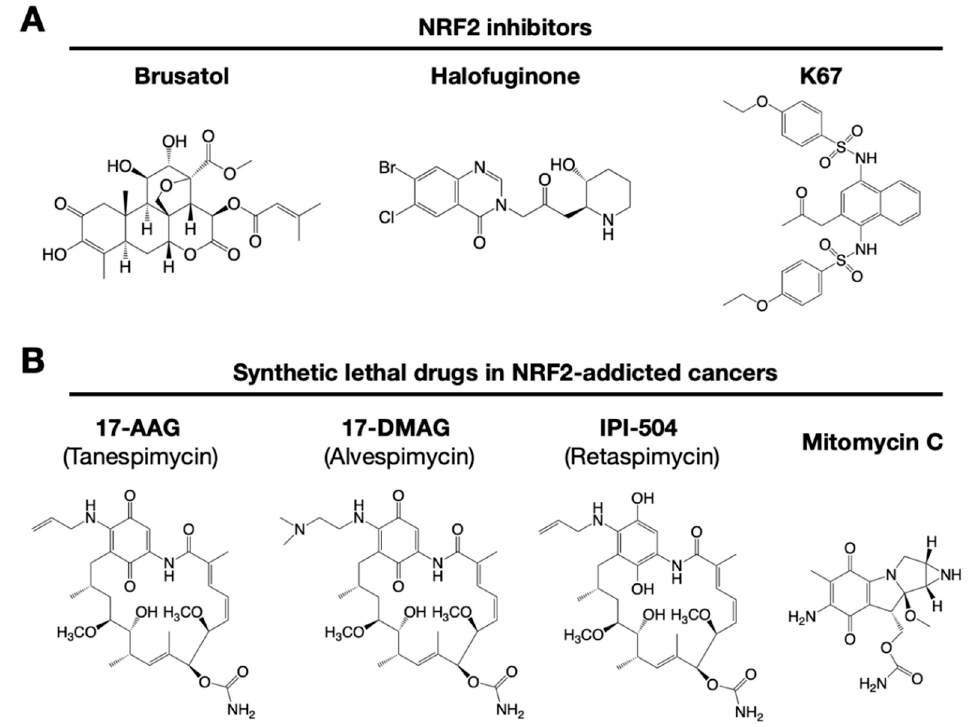
Figure 4. Small chemical inhibitors targeting NRF2. ( A ) NRF2 inhibitors: brusatol, halofuginone and K67. ( B ) Synthetic lethal drugs for NRF2-addicted cancers: 17-AAG (tanespimycin), 17-DMAG (alvespimycin), IPI-504 (retaspimycin) and mitomycin C.